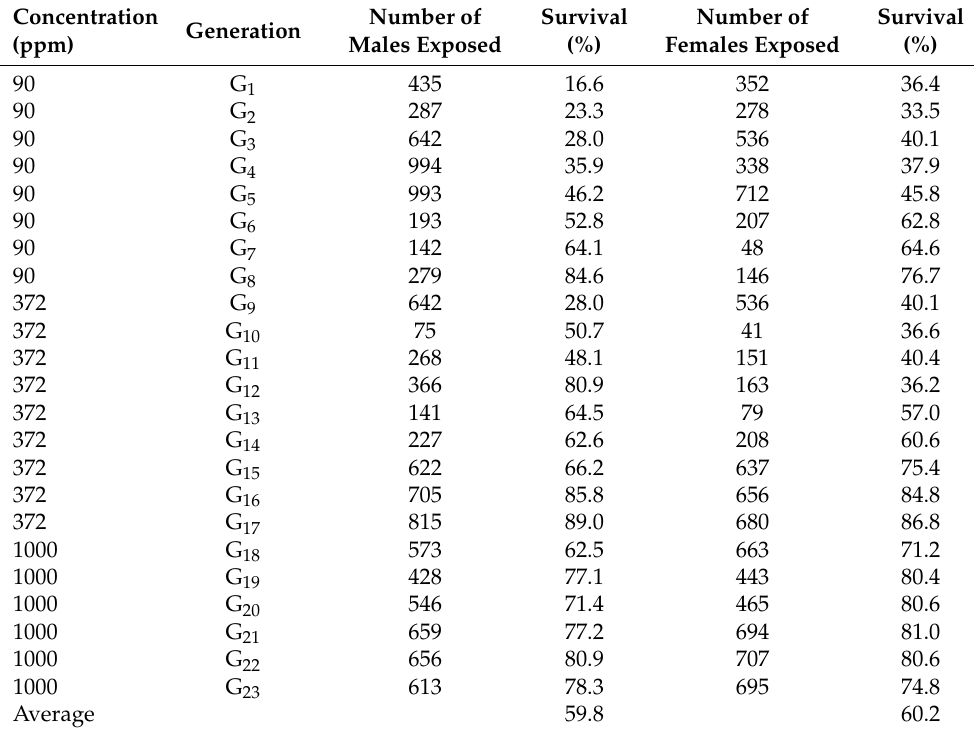
Table 2. Screening history of alpha-cypermethrin-selected strain of Musca domestica